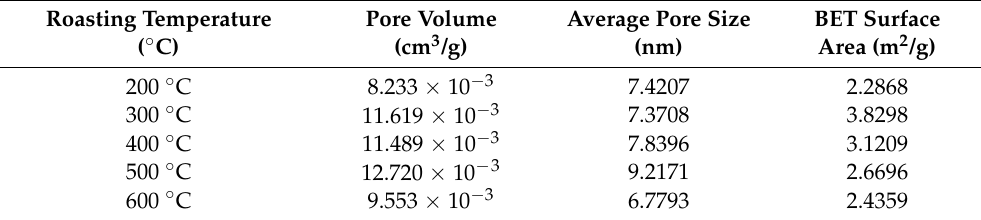
Figure 9. Adsorption and desorption isotherm of tantalum niobium slag to N 2 . Table 9. The tantalum-niobium slag after roasting performance